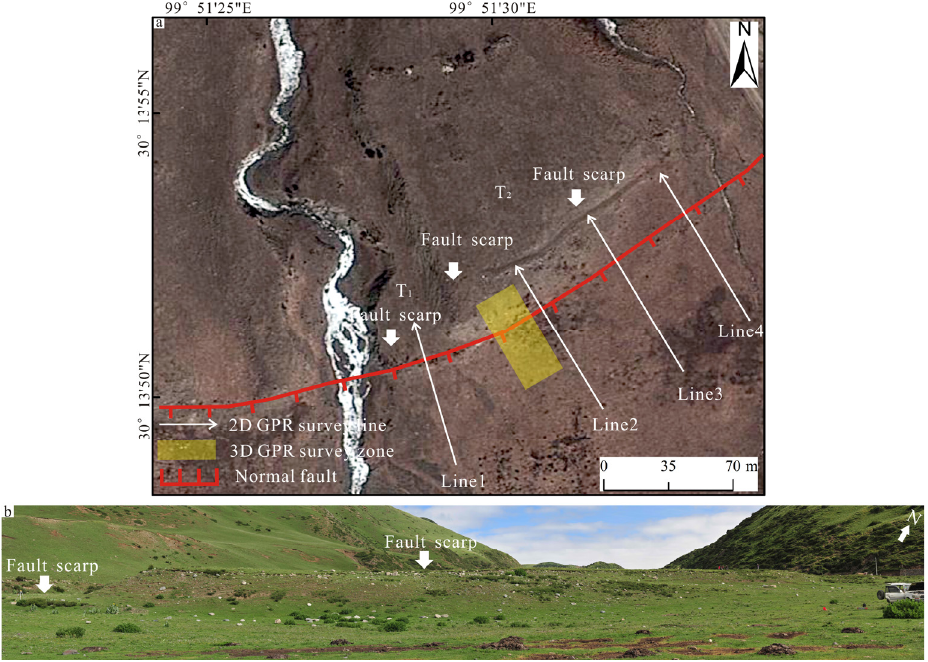
Figure 3. Google Earth image and the panoramic image of the study site (the red rectangular box in Figure 2). ( a ) Google Earth image of the study site. Red lines represent the identified faults at the surface. White lines are the 2D 250 MHz and 500 MHz GPR survey lines. The yellow rectangular box indicates the 3D GPR survey zone. ( b ) The panoramic image of the study site.